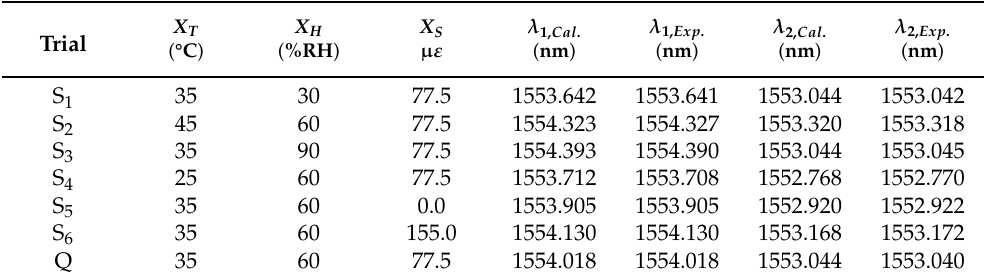
Table 7. Computational and experimental results of the Bragg wavelength of the control points in Figure 1 for gratings #1 and #2.